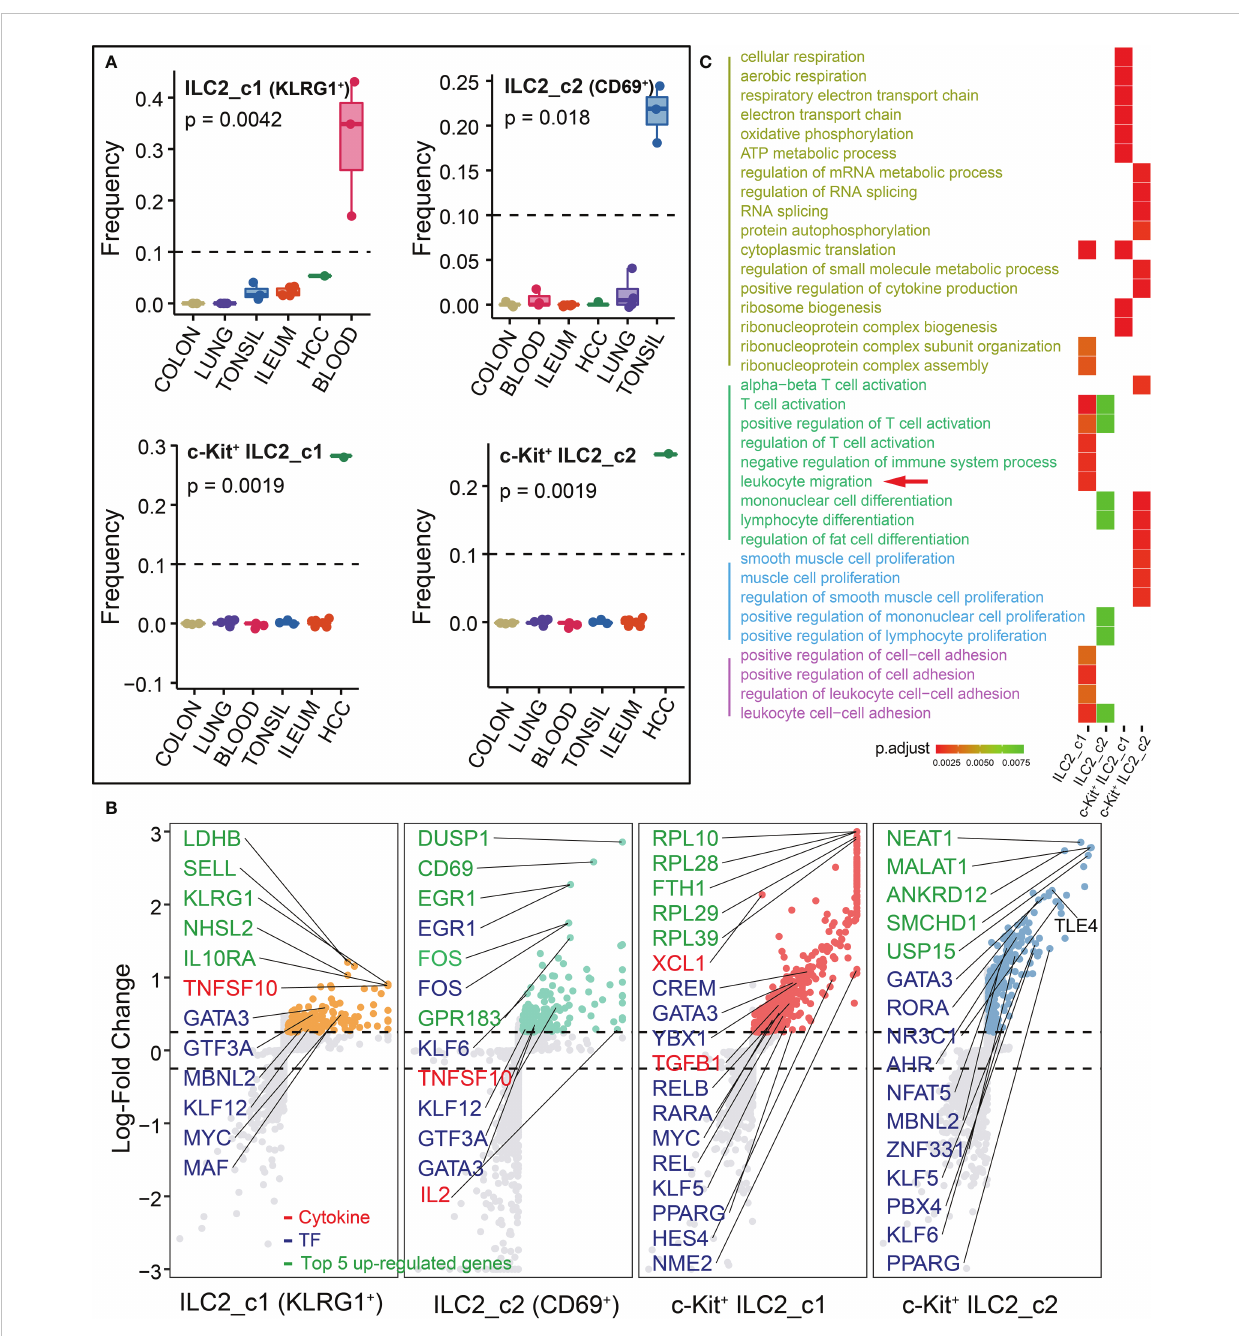
FIGURE 4 Characterization of ILC2s in different tissues. (A) Box plots showing the frequencies of four ILC2 subsets (divided by the total CD127 + ILC number) in lung, colon, ileum, tonsil, blood and HCC. P values were calculated from Kruskal-Wallis test. (B) Differential gene expression analysis showing up- and down-regulated transcripts across four ILC2 subsets. (C) Functional enrichment analysis showing top 15 GO terms in each ILC2 subset of biological